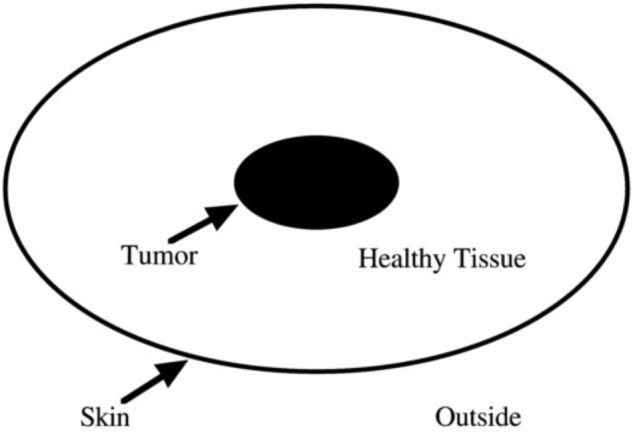
A schematic diagram of the Duncker’s radiation problem.